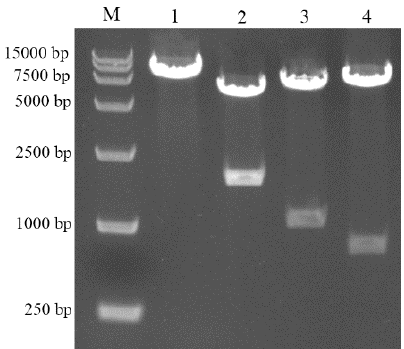
Figure 4. Agarose gel electrophoresis analysis of double-restriction-enzyme digested plasmid pDG364-CotB-VP8*. M: DNA marker; lane 1–4: products from recombinant plasmid digested with